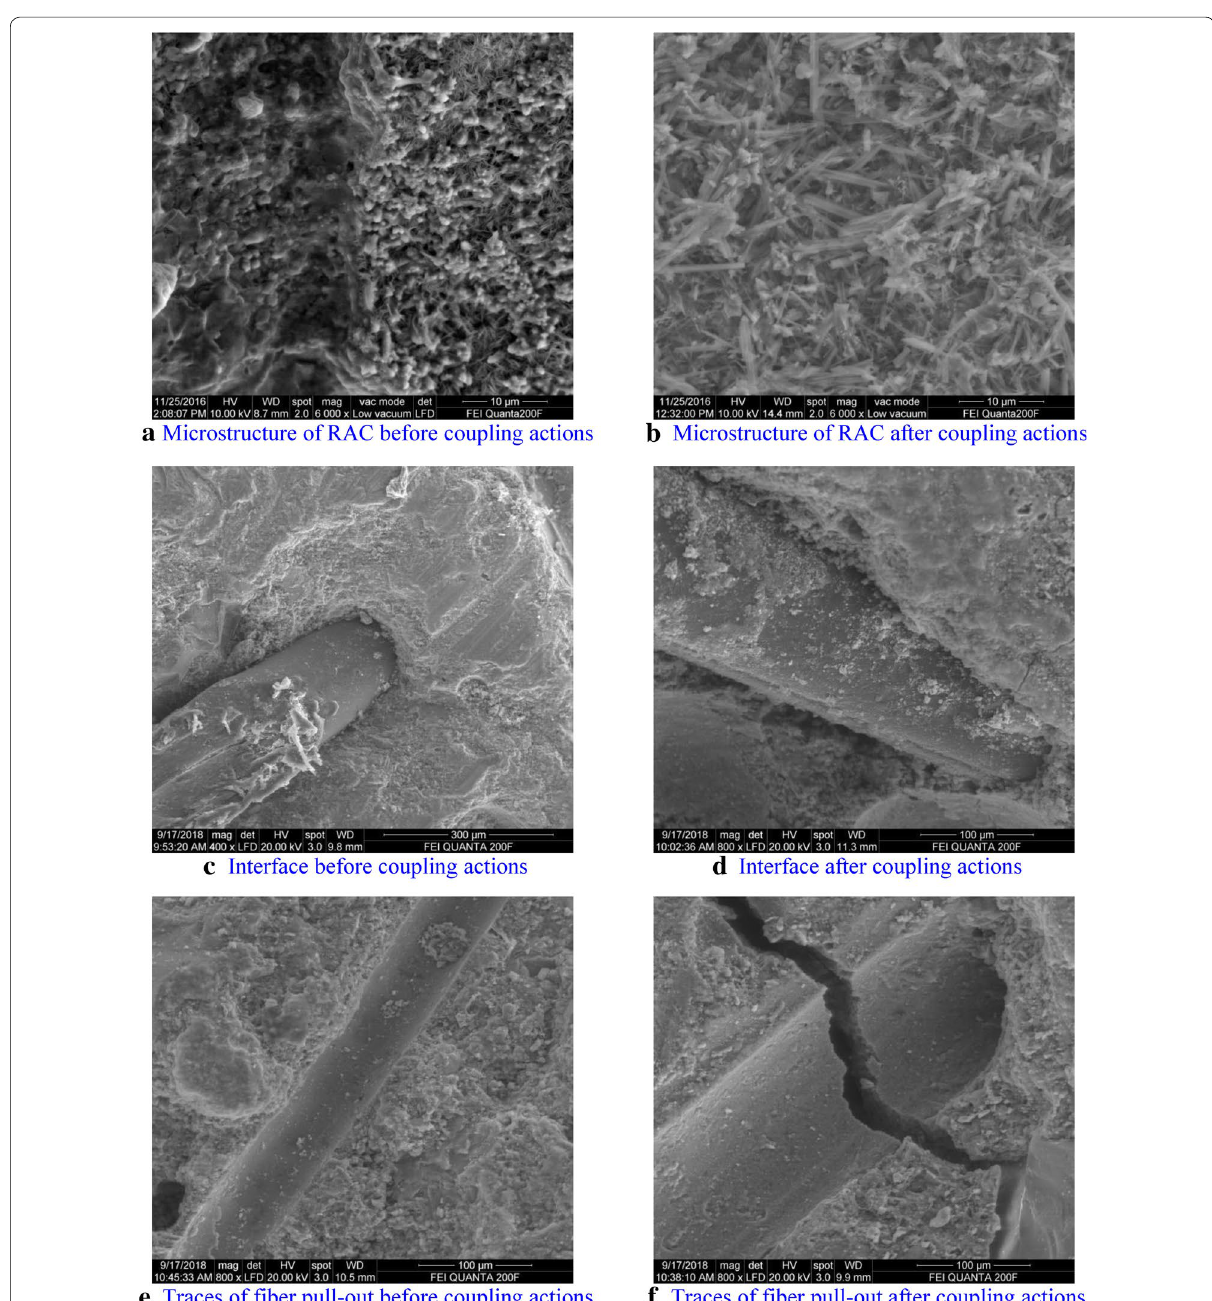
Fig. 10 Microstructure of RAC before and after the coupled actions of mechanical loading and salt-solution freeze–thaw cycles: microstructure of RAC a before, b after coupled actions; interface c before and d after coupled actions; and traces of fiber pull-out e before, and f after coupled